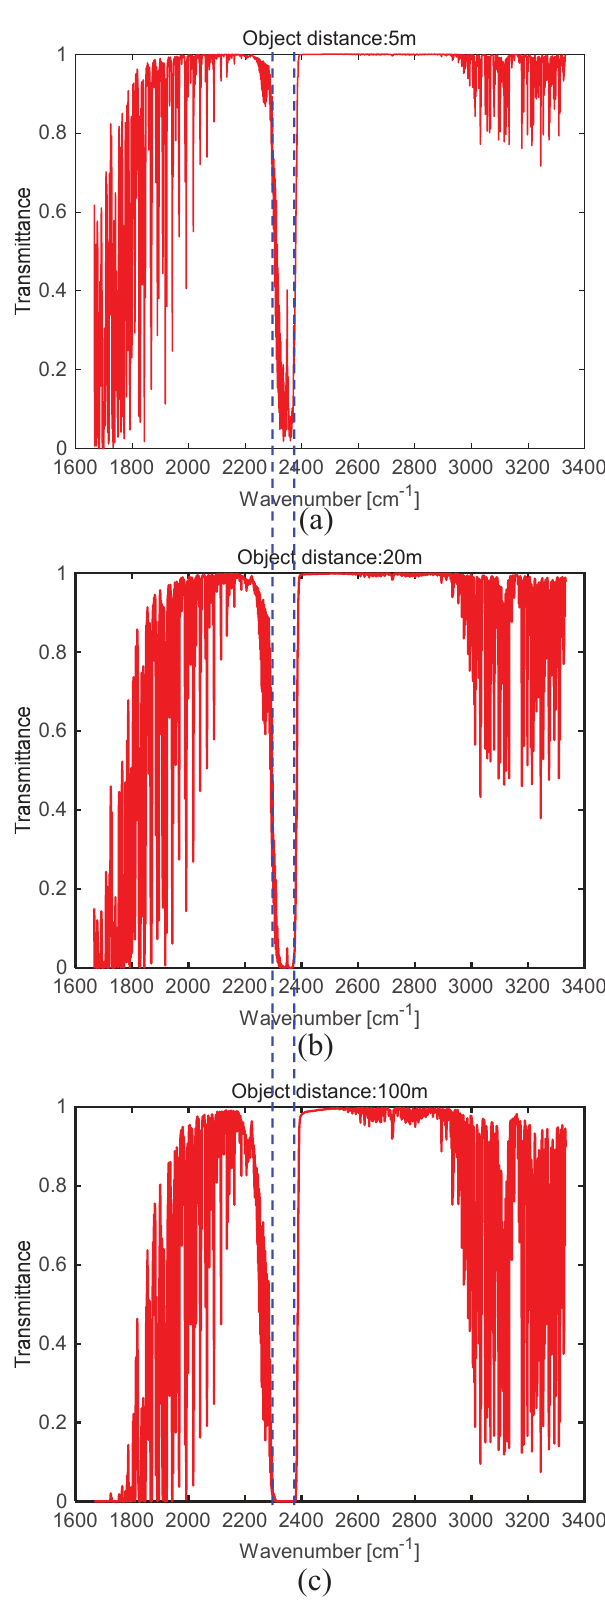
Figure 3. Spectral transmittance according to ship-camera distance in the MWIR band: ( a ) 5, ( b ) 20, and ( c ) 100